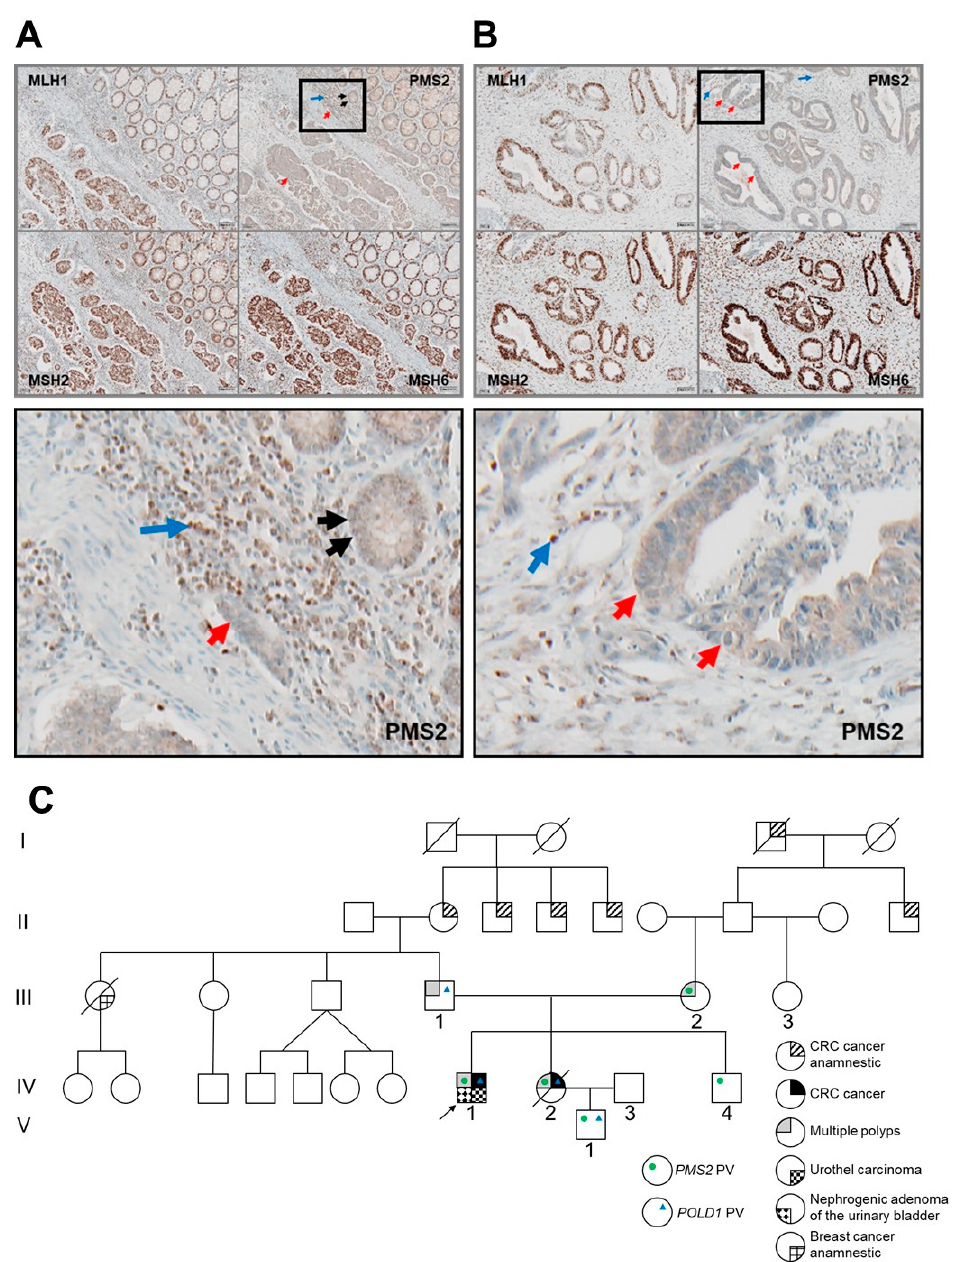
Figure 1. Immunohistochemical staining of mismatch-repair (MMR) proteins (PMS2, MLH1, MSH2 and MSH6) in the tumor of the index patient ( A ) and his sister ( B ). Loss of PMS2 expression is seen in carcinoma epithelia (red arrows) but not in tumor-infiltrating leukocytes (blue arrows; A , B ). PMS2 expression is also absent or strongly reduced in the patient’s non-dysplastic crypts adjacent to carcinoma tissue (black arrows) ( A ). An enlarged view of the relevant areas (black box) is shown below the upper panels ( A , B ). In the pedigree of the family ( C ), the identified germline pathogenic variants (PVs), PMS2 :c.2007-786_2174+493del1447 (green points) and POLD1 :c.946G>A (blue